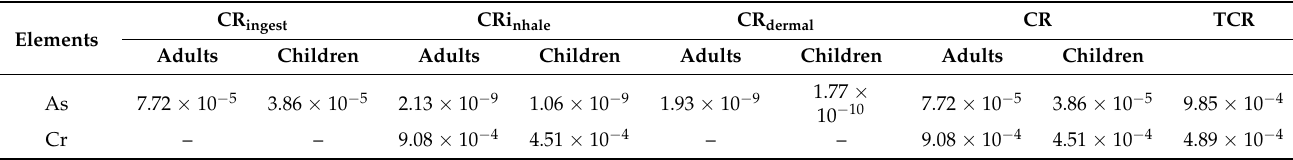
Table 7. The carcinogenic risk index values of heavy metals in soils in the study